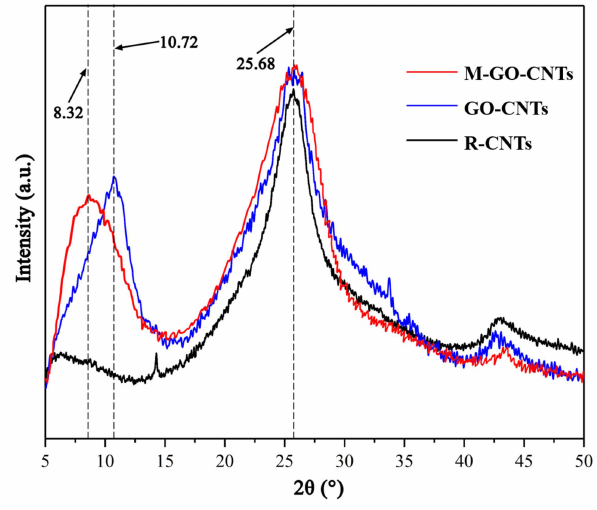
Figure 6. XRD spectra of R-CNTs, GO-CNTs, and